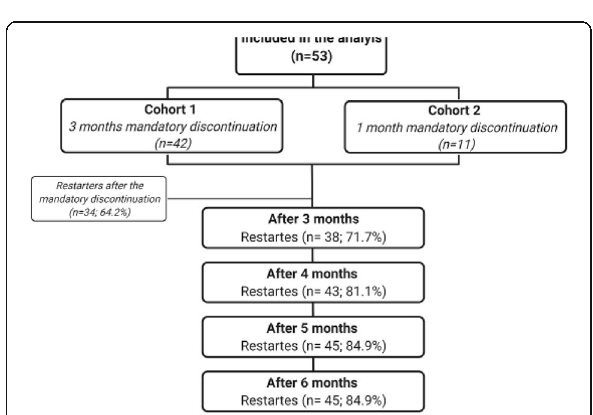
Fig. 2 (abstract P259). See text for